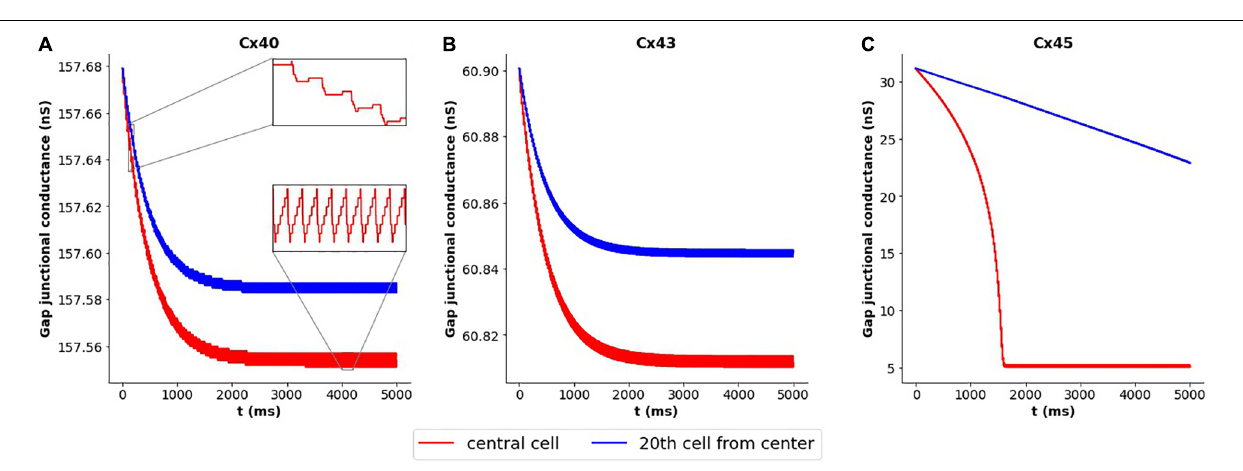
FIGURE 6 | Variation in gap junctional conductance over the course of a simulation, with 1-D model having HH mechanism, while the cell is exhibiting AP oscillations. Panels show results for different gap junction subtypes: (A) Cx40, (B) Cx43, and (C) Cx45. Red trace represents the central cell, while the blue trace represents the 20th cell away from the central cell. The overall change in gap junctional conduction is very low ( < 0.2%) for Cx40 and Cx43, while Cx45 exhibits a significant fall ( ∼ 84%) in gap junctional